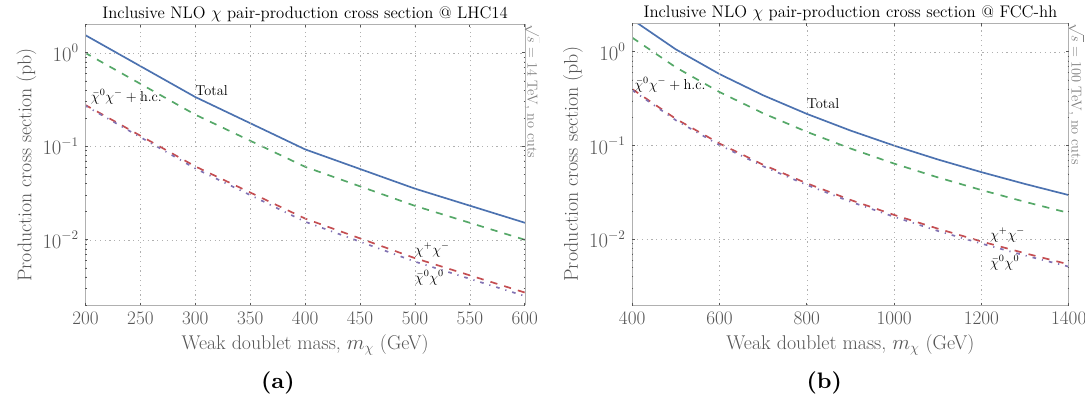
Figure 1 . Corrected pair-production cross sections for a weak doublet with hypercharge 1 obtained using PROSPINO in the pure-Higgsino limit, for LHC14 (a) and FCC-hh (b).